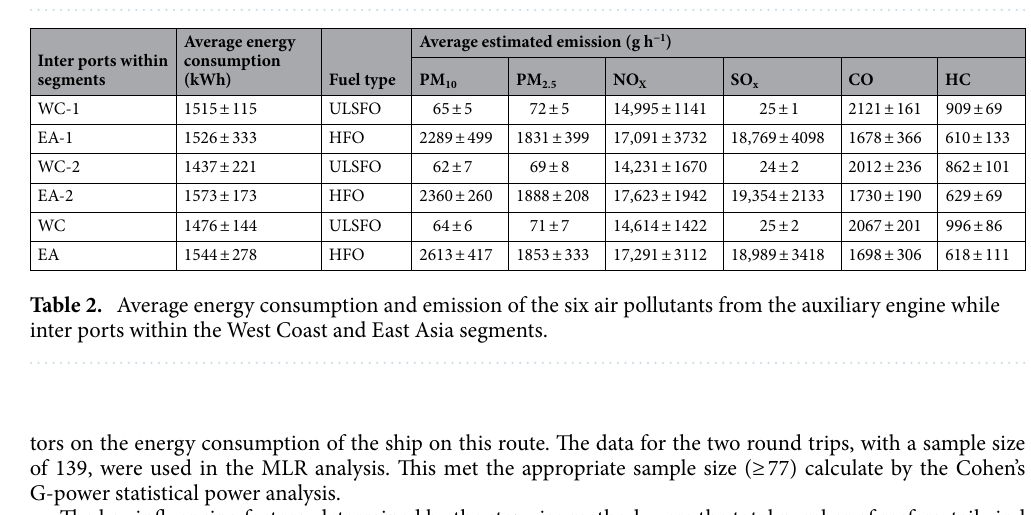
Inter ports within